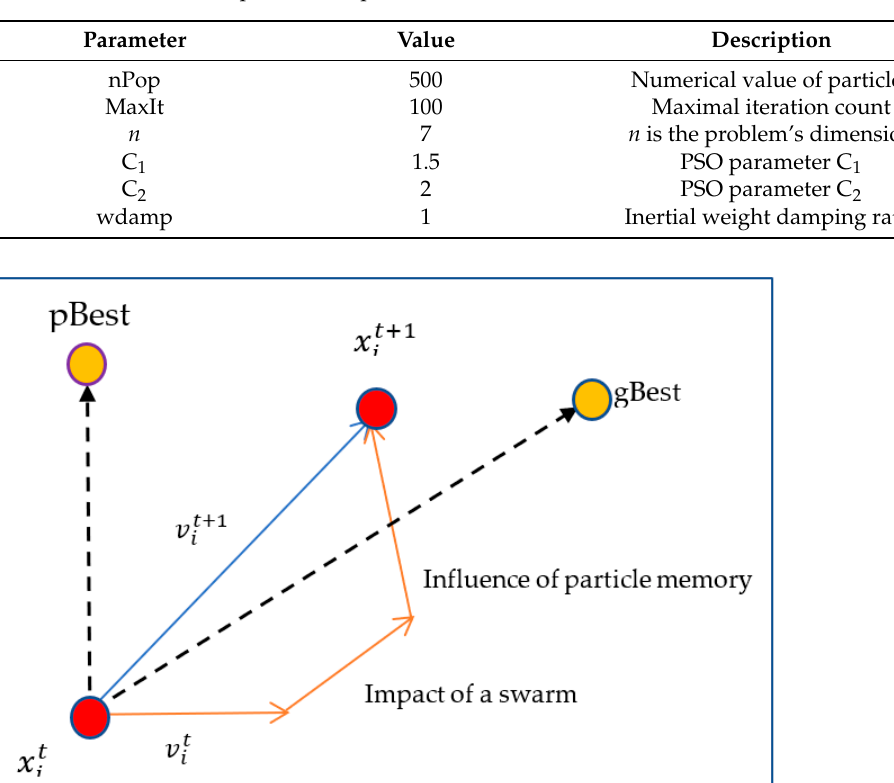
Table 1. Particle swarm optimization parameters.